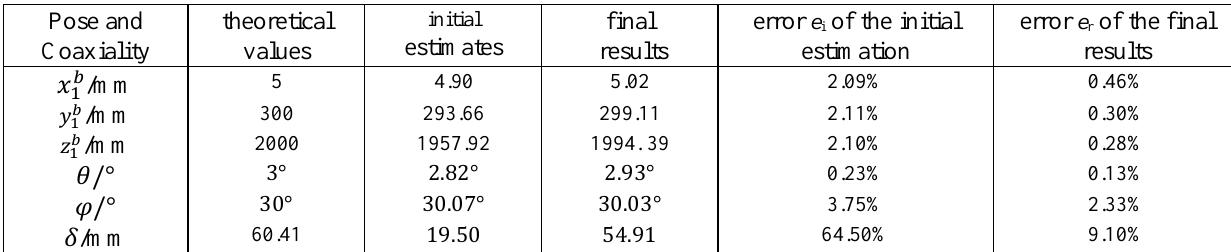
Table 2. Simulation experimental